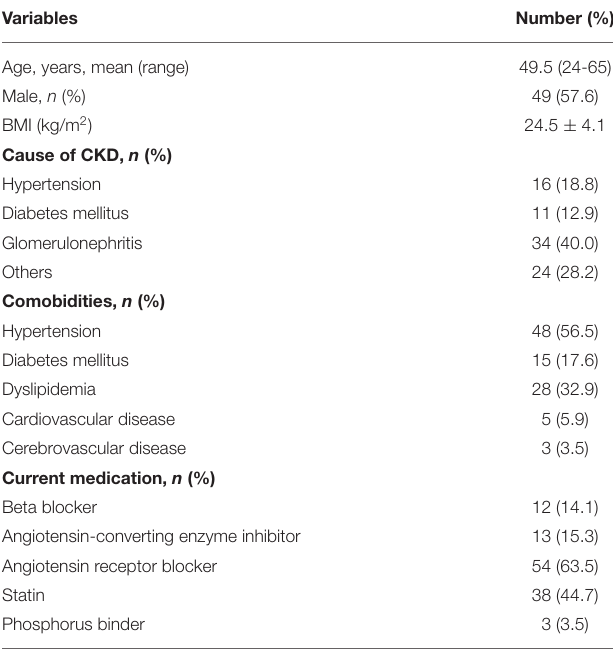
TABLE 1 | Baseline characteristics. TABLE 2 | Biochemical and vascular